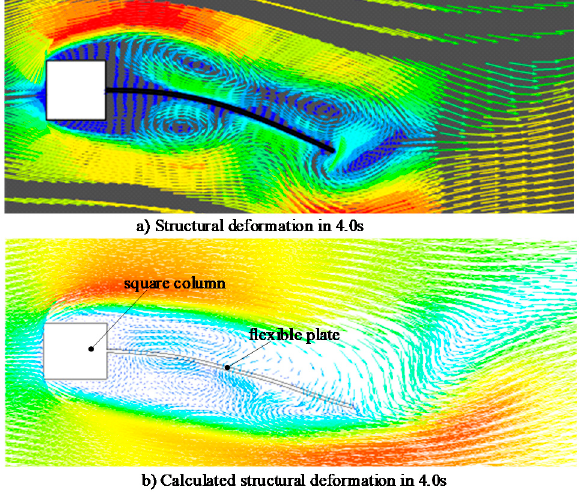
Figure 5. Comparison of calculated instantaneous deformation of flexible plate at t = 4.0 s with result in Ref. [23].